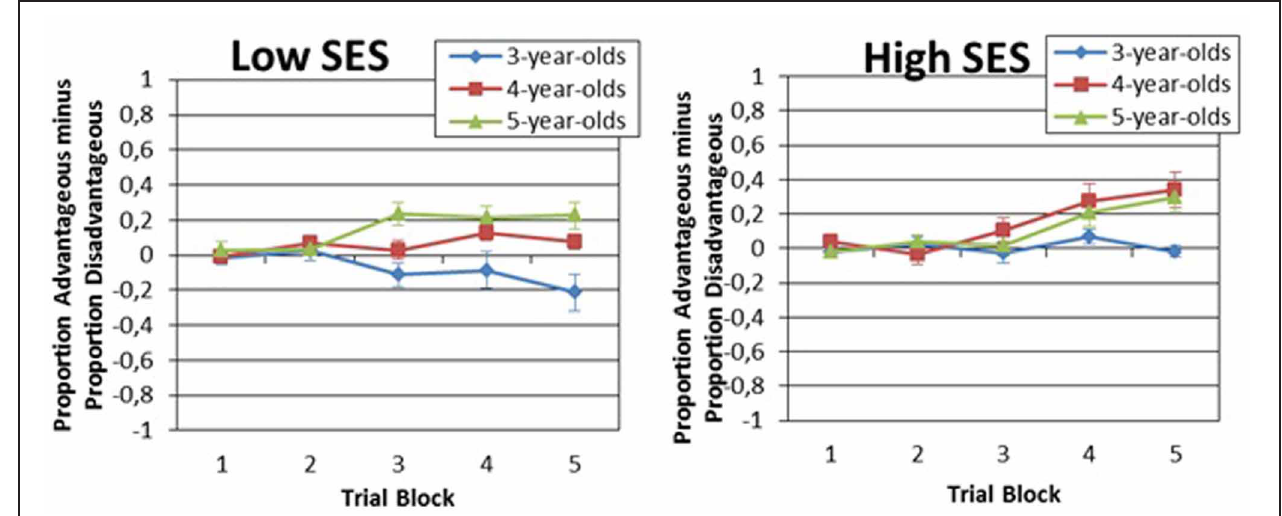
FIGURE 3 | Performance of each of the 3 aged groups according to SES groups.